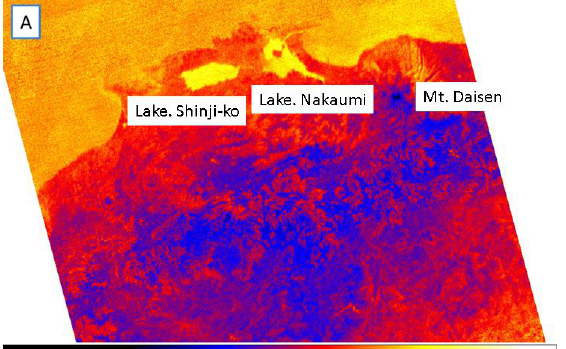
Figure 7. Zoom of the region A from Figure 6.